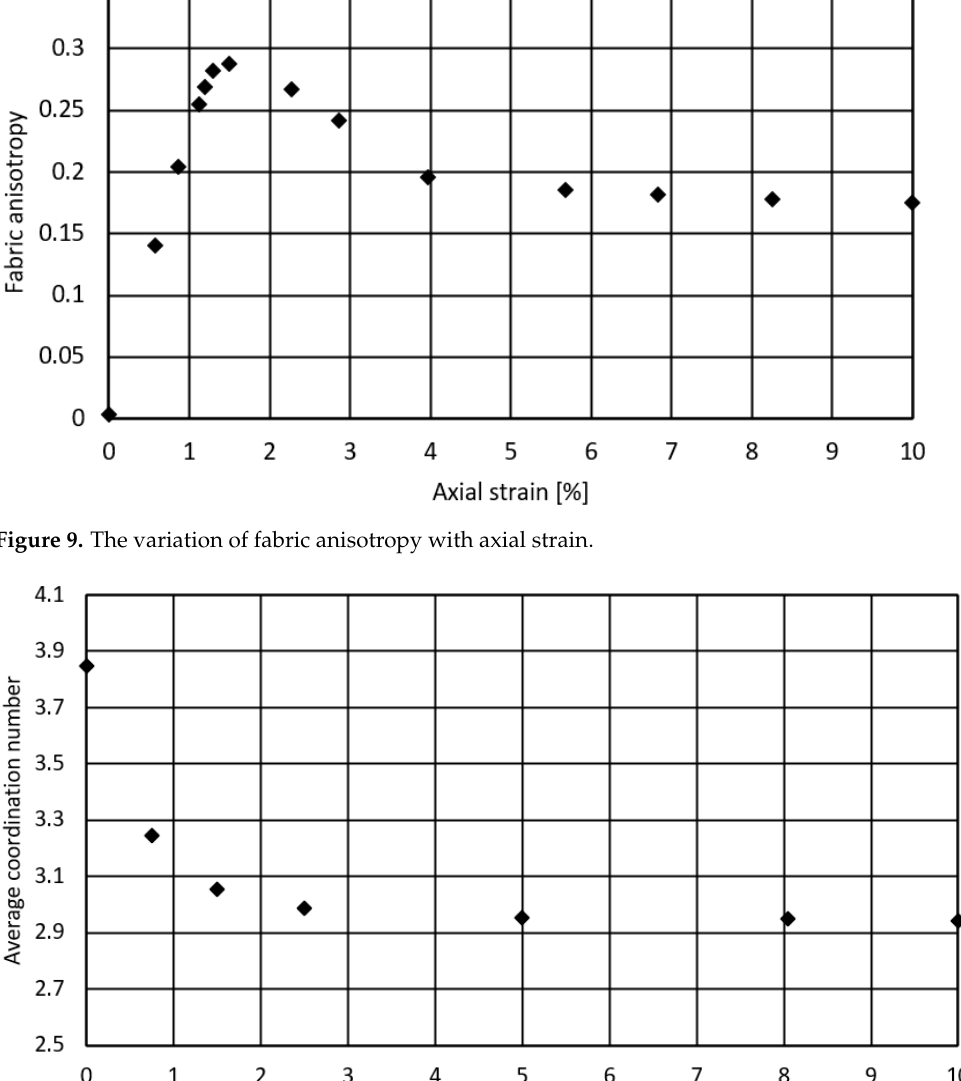
11 Figure 8. The variation of stress ratio vs. axial strain. The microscopic behavior of the sample being considered is shown in Figures 9 and 10. In spite of showing a linear trend until 𝜀 (cid:2869)(cid:2869) = 0.5% in Figure 8, changes at the micro- scopic level are not a reversal. It is due to permanent change in the fabric of a particulate system such that the fabric anisotropy increases rapidly from 0.0034 at 𝜀 (cid:2869)(cid:2869) = 0% (i.e., iso-